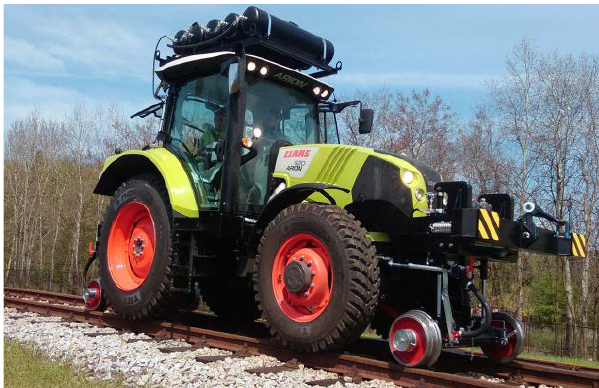
Fig. 1. Rail-road tractor design based on the CLAAS Arion